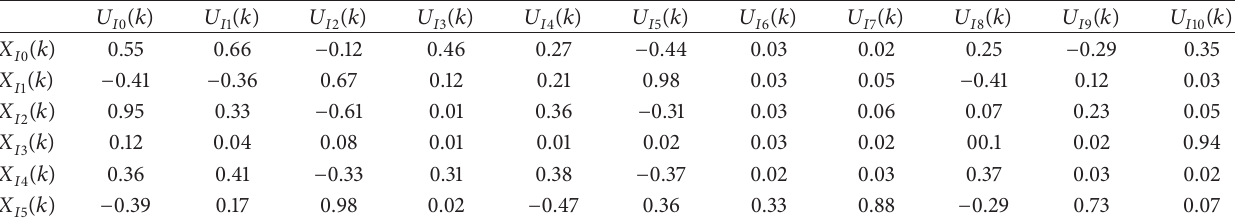
of the sensitivity of conscious reaction. YF